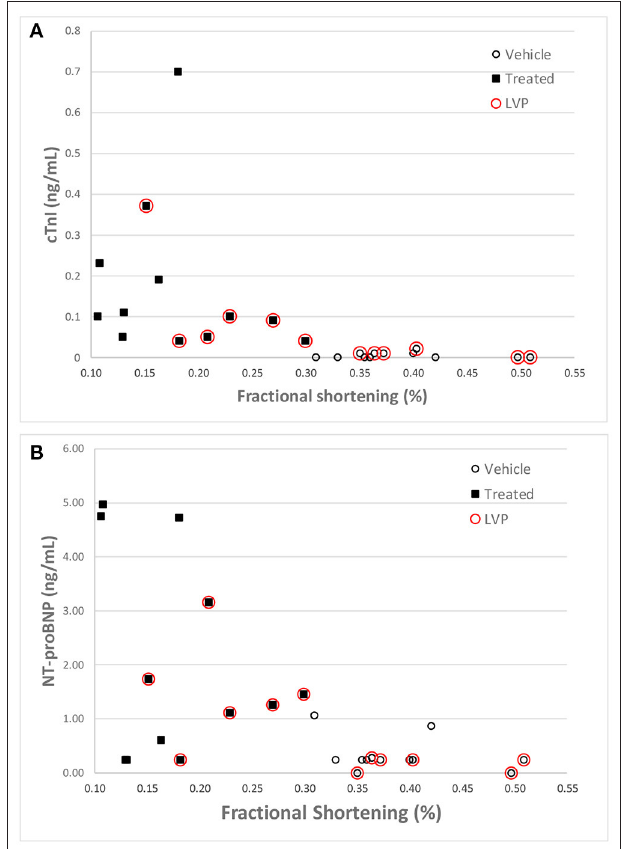
FIGURE 8 | Correlation of cTnI (A) and NT-proBNP (B) levels with Fractional Shortening measurements at the final echocardiography measurement for each animal. Red circles denote animals equipped with LVP catheters.